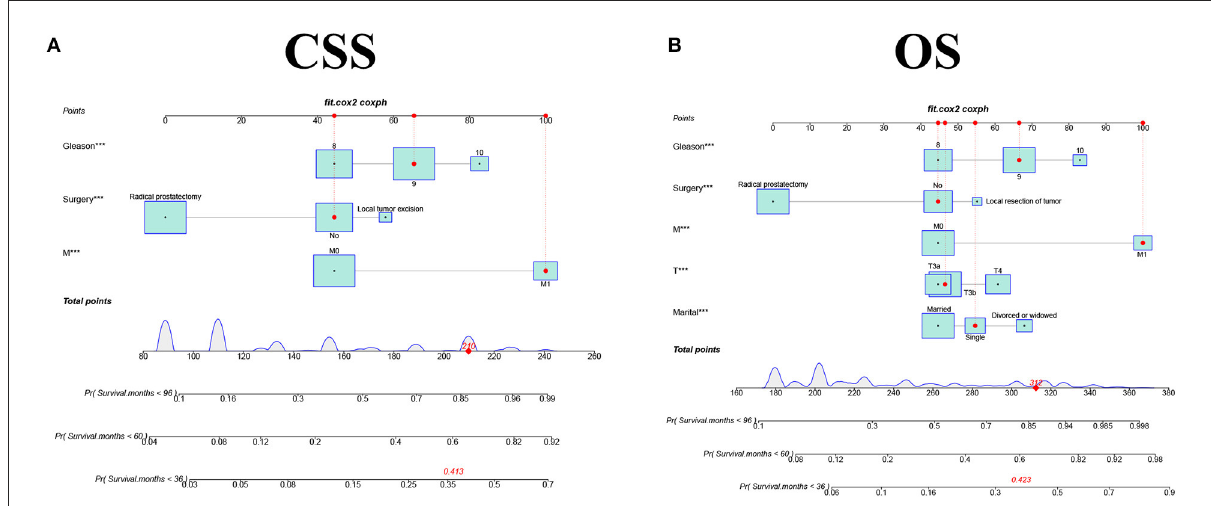
FIGURE2 The nomograms for predicting 3-, 5-, and 8-year CSS and OS in middle aged high-risk prostate cancer. (A) The nomogram for predicting CSS. (B) The nomogram for predicting